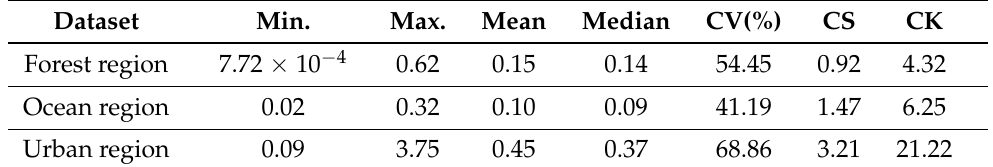
Figure 2. Images used in measured SAR data applications: ( a ) single-look VHF UWB SAR image referring to a forest region in northern Sweden, ( b , c ) four-look L-band SAR images referring to the ocean and urban areas, respectively, from San Francisco, California. Table 2. Summary statistics of